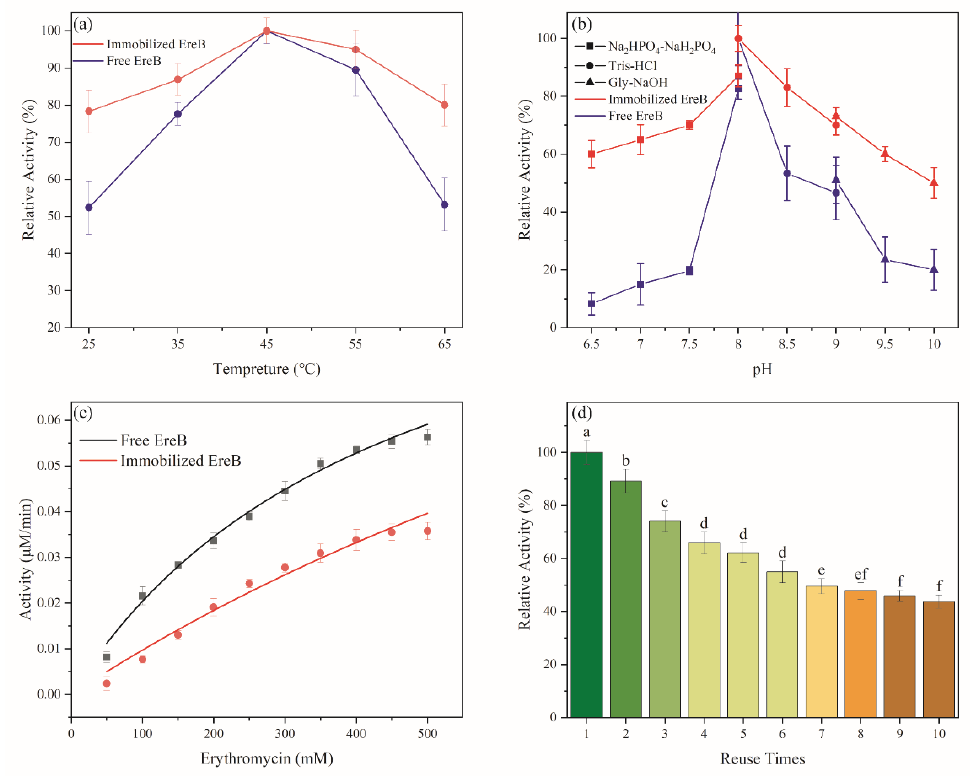
Figure 6. Characterization of the enzymatic properties of free EreB and EreB@modified palygorskite. Effects of: ( a ) temperature and ( b ) pH on the relative activity at their own optimal pH (8.0) and temperature (45 ◦ C), respectively. ( c ) Kinetic analysis of free EreB and immobilized EreB. ( d ) Recycling performance of EreB@modified palygorskite. The letters above different columns addressed not by the same letter are significantly different according to student’s t test, ( p <